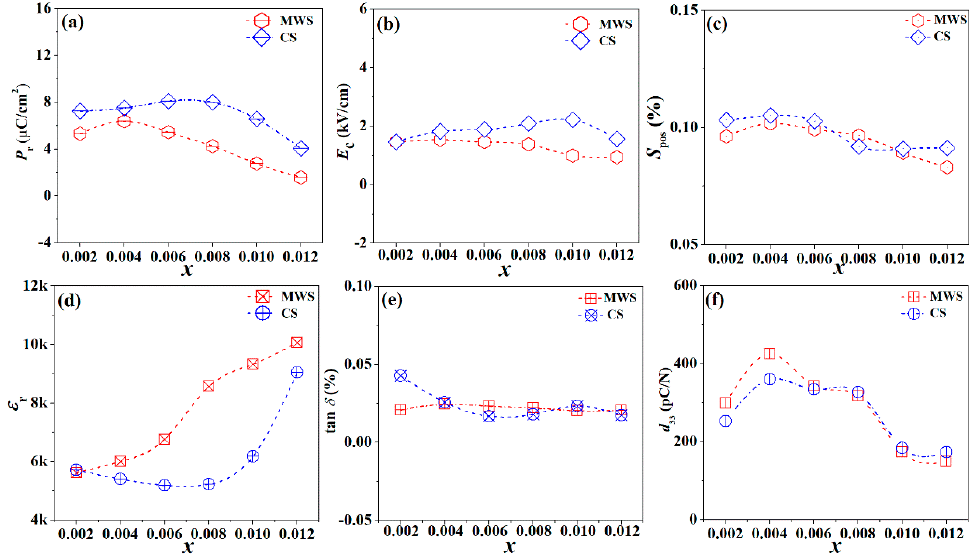
Figure 6. ( a ) P r , ( b ) E c , ( c ) S pos , ( d ) ε r , ( e ) tan δ , and ( f ) d 33 of BTS-BCT- x BF ceramics sintered with MWS and CS.